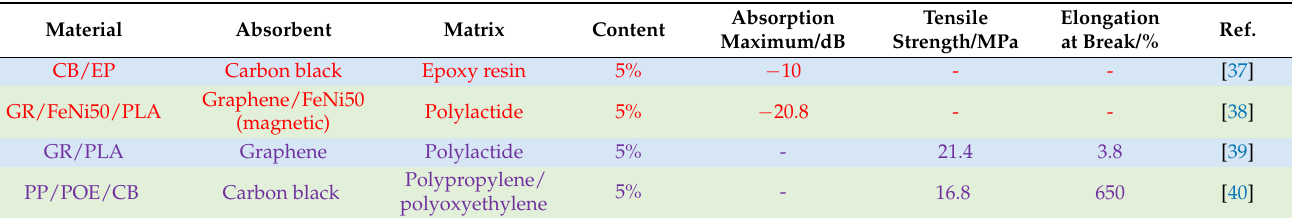
Table 5. Comparison of properties between carbon-based absorbent particles and resin matrix composites in recent